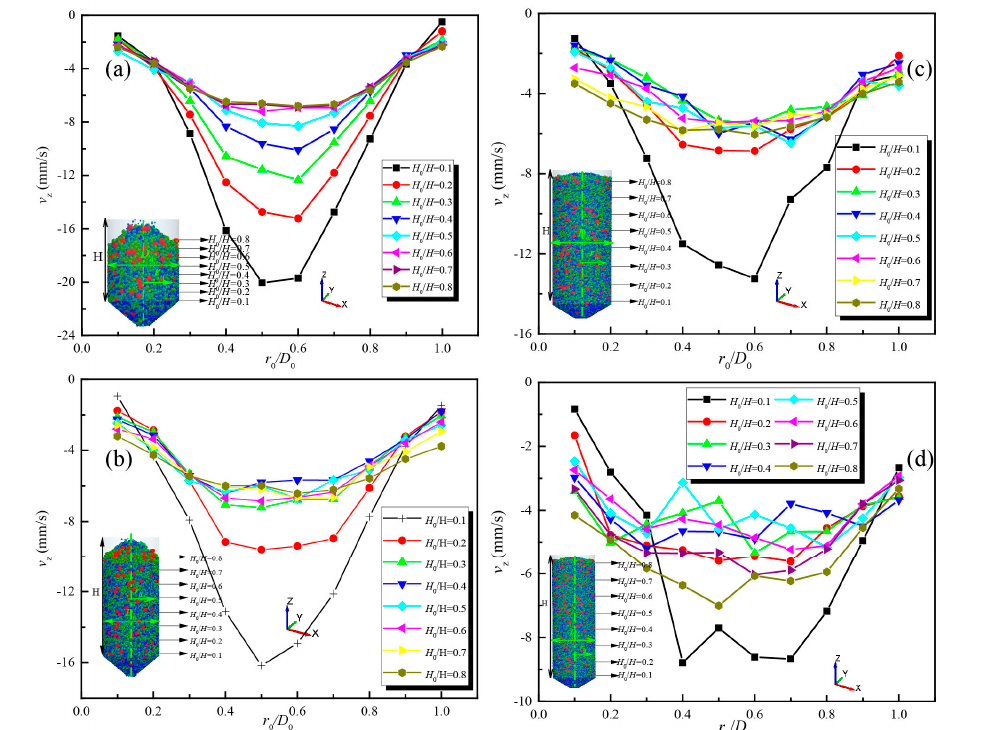
Figure 4. The variation in velocity profiles with different aspect ratios of ( a ) H/D 0 = 1, ( b ) H/D 0 = 2, ( c ) H/D 0 = 3, and ( d ) H/D 0 = 4.